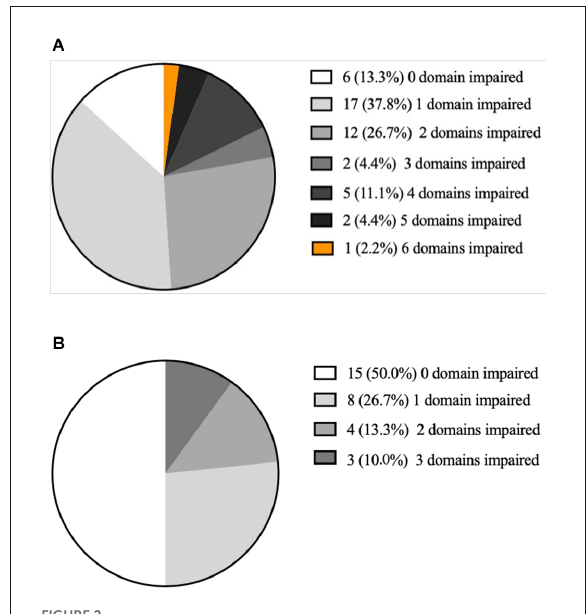
FIGURE2 The number of impaired cognitive domain in each patient with cerebellar infarction (A) and healthy control (B) .